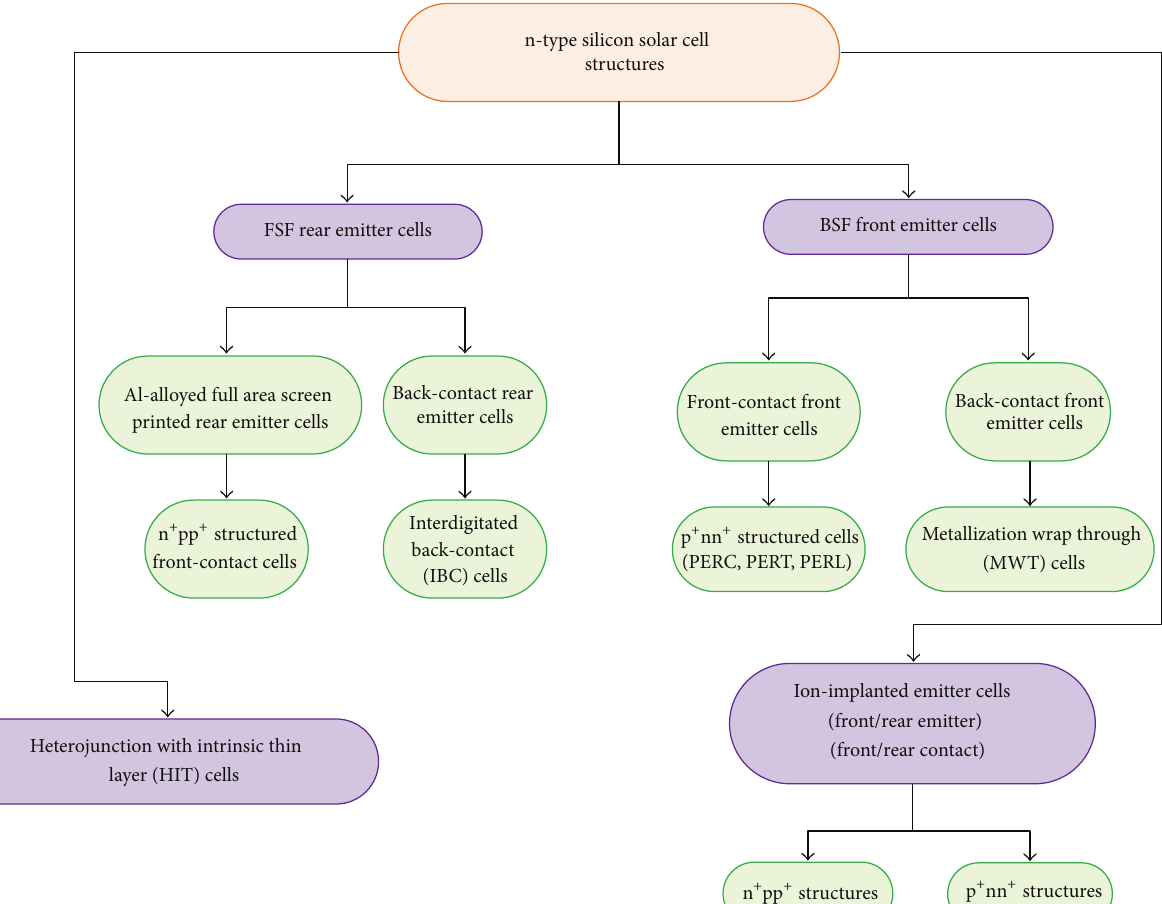
Figure 1: The flow chart of the possible cell structures using n-type silicon